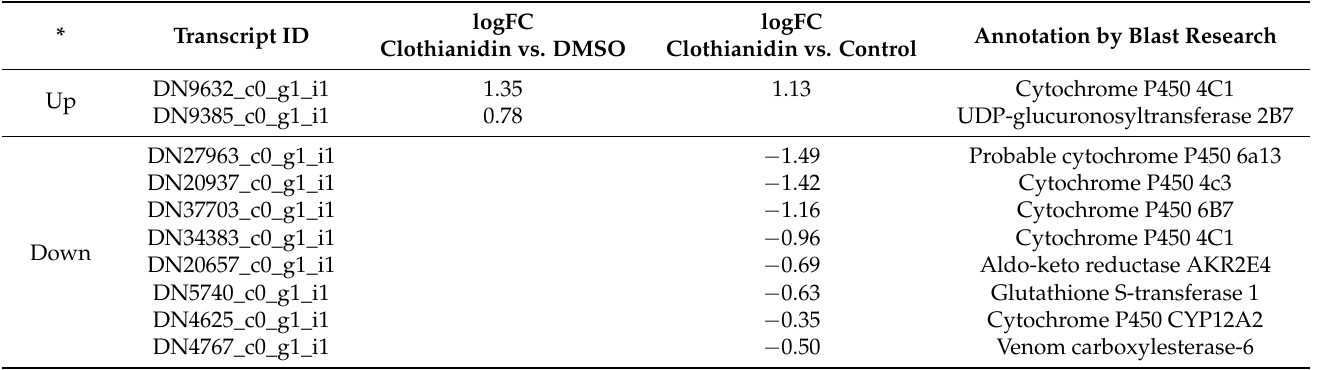
Table 3. Clothianidin exposure affects the transcript abundance of detoxification